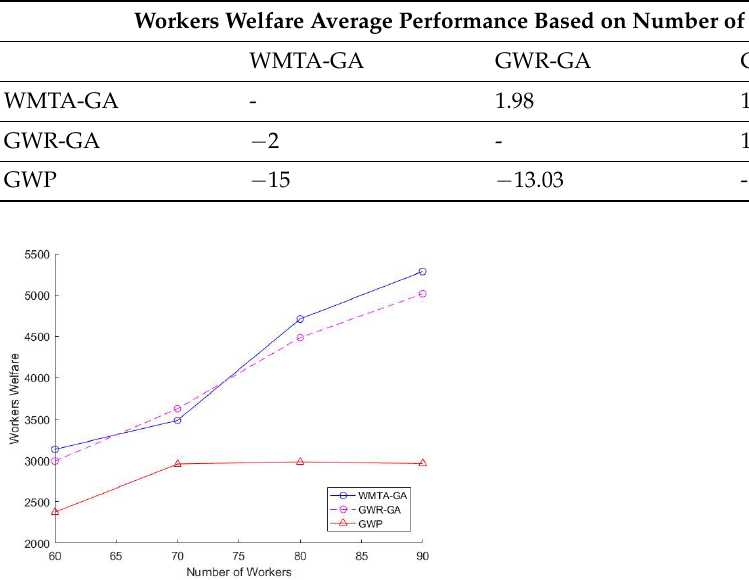
Table 3. Average performance w.r.t Varying Number of Workers.